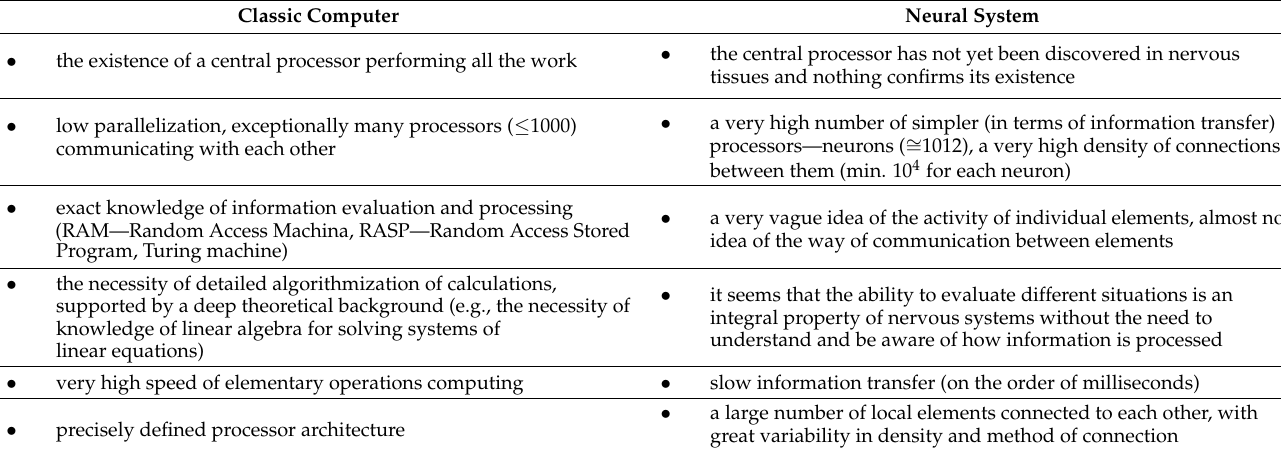
Table 1. Comparison of the basic properties of a classical computer and a neural